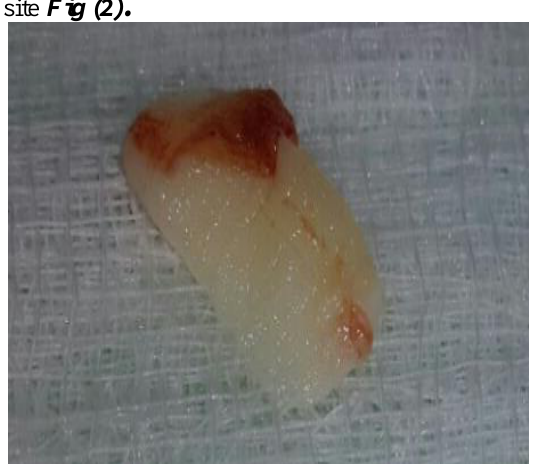
Figure (2): PRF clot after